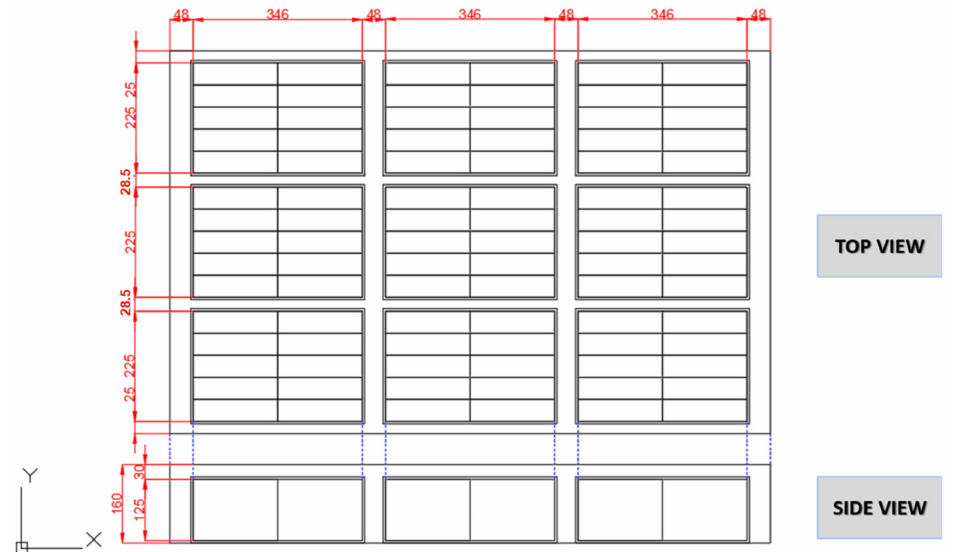
Figure 4. Pack schematic of configuration 1 with prismatic cells in the floor integration installation of reference